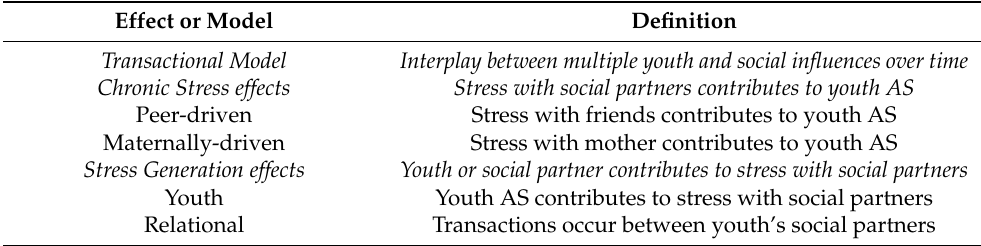
Table 1. Definition of effects and